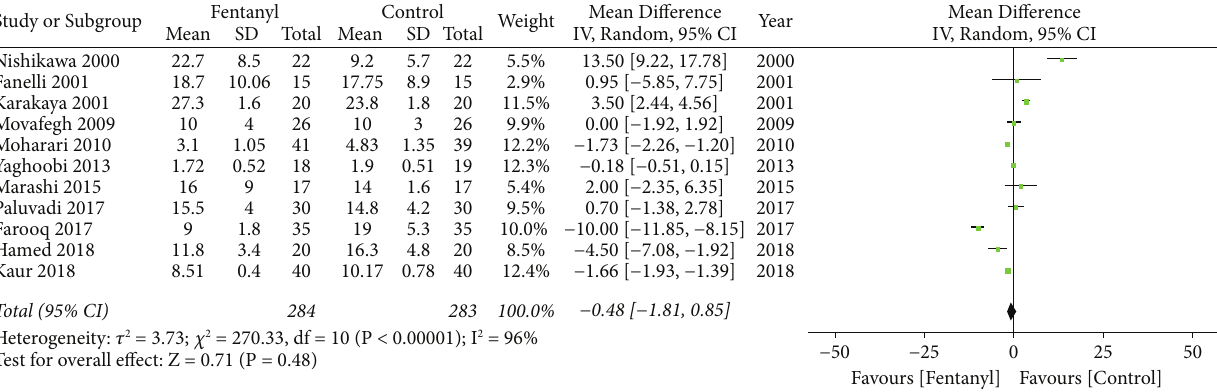
Figure 3: Meta-analysis of onset of sensory anesthesia between fentanyl and control groups.